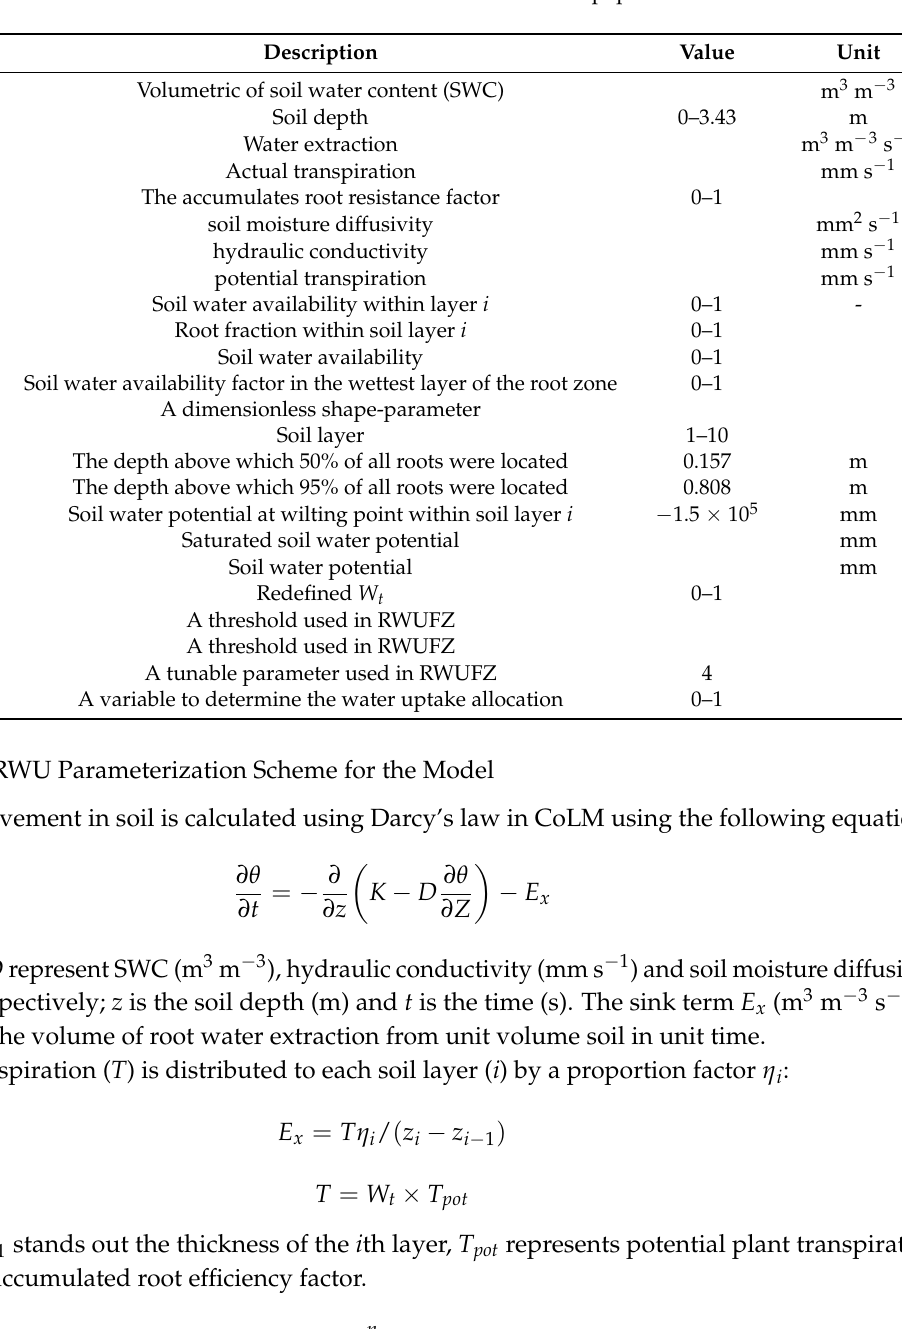
Table 1. Parameters and variables used in this